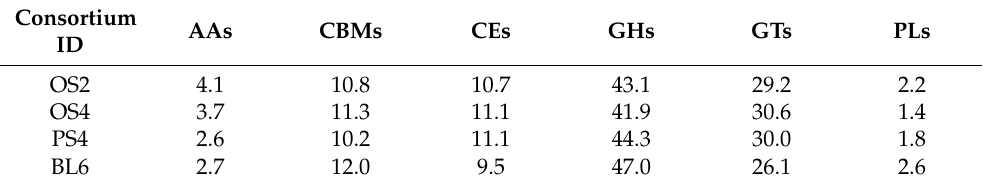
Table 3. CAZy module composition in metagenomes of isolated microbial consortia, % of CAZy count. AAs—Auxiliary Activities, CBMs—Carbohydrate-Binding Modules,